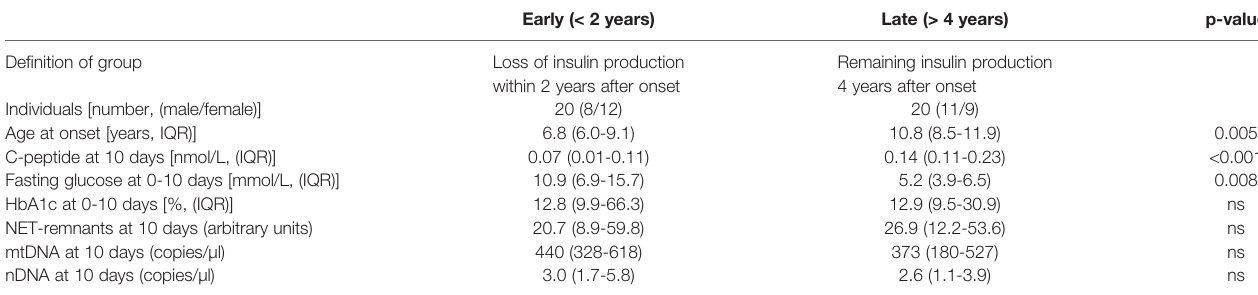
TABLE 3 | Characteristics of T1D children with early (< 2 years) and late (> 4 years) loss of endogenous insulin